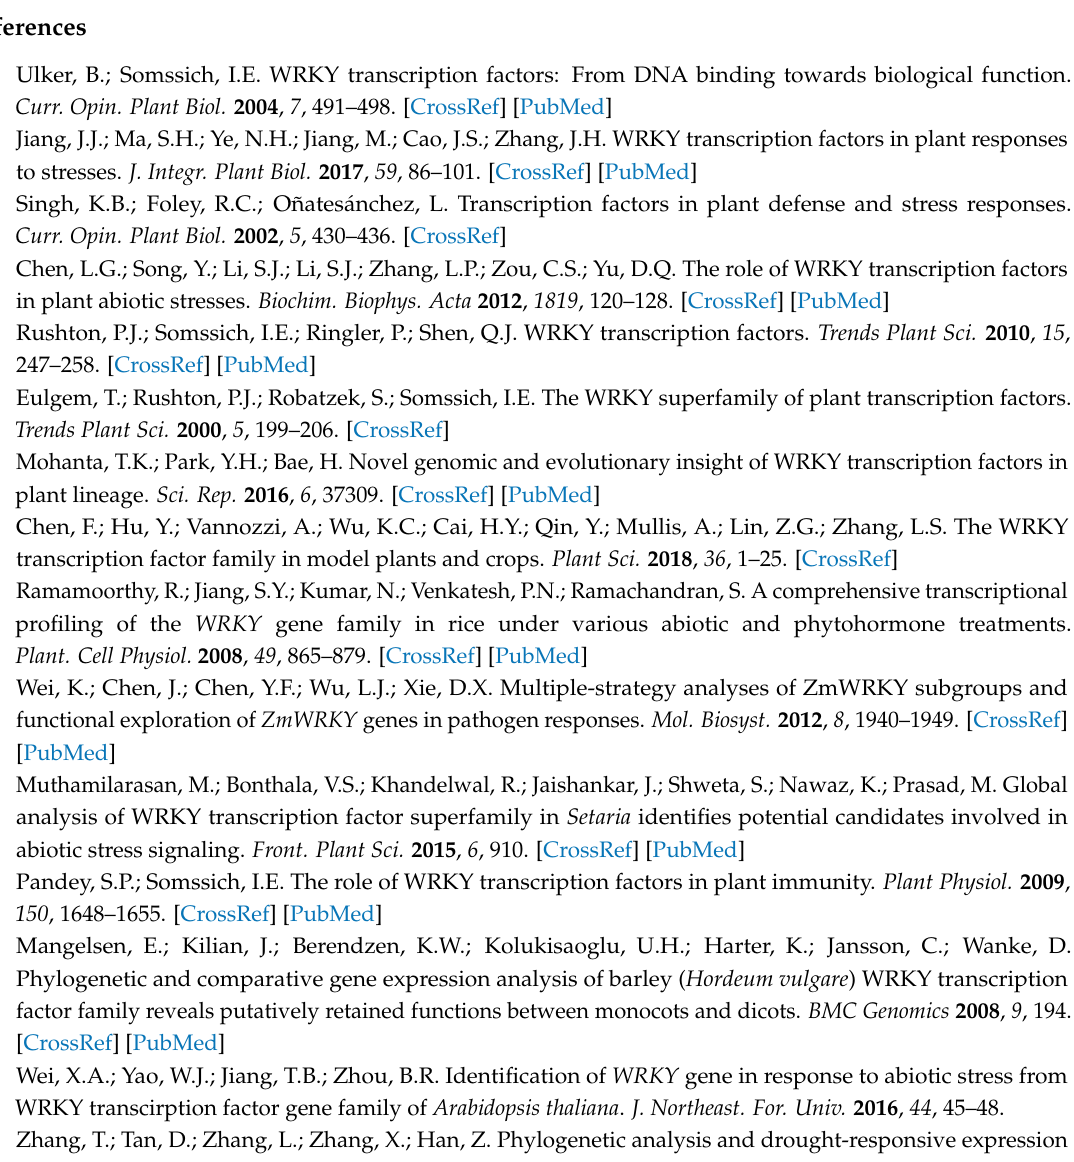
plant hormone stress; Table S6. Raw calculations of expression of the ScWRKY3 gene after infection with smut pathogen; Table S7. Raw calculations of the transcript level of nine immunity-associated marker genes in the Nicotiana benthamiana leaves after one day of agroinfiltration; Table S8. Raw calculations of the transcripts of nine immunity-associated marker genes in the Nicotiana benthamiana leaves after inoculation with Ralstonia solanacearum for one day and seven days; Table S9 . Raw calculations of the transcripts of nine immunity-associated marker genes in the Nicotiana benthamiana leaves after inoculation with Fusarium solani var. coeruleum for one day and seven